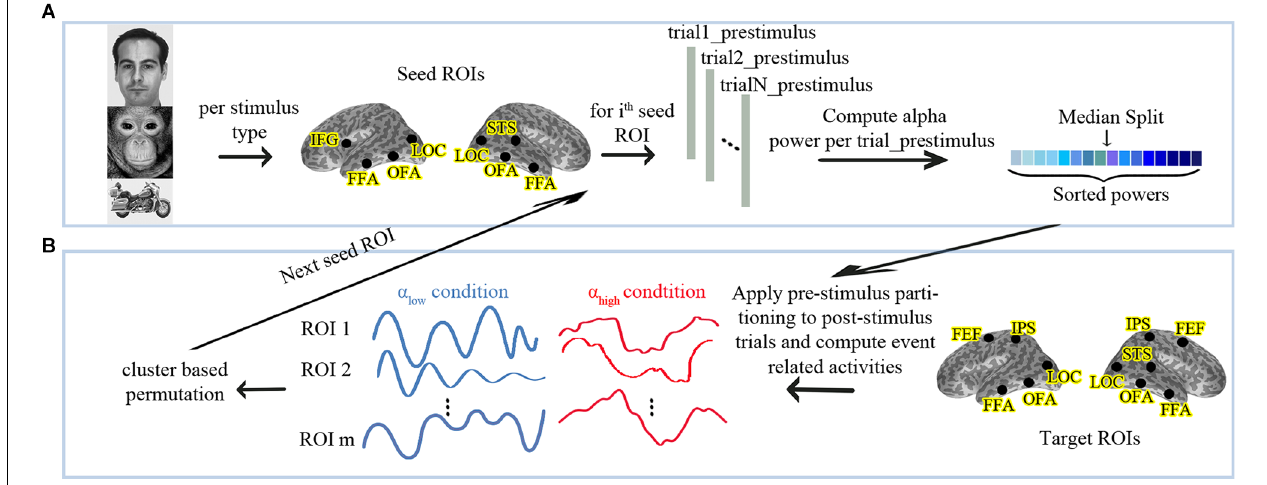
FIGURE 1 | (A) Analysis pipeline for partitioning the data into high vs. low pre-stimulus alpha conditions and (B) follow-up statistics. α low : Low Pre-stimulus Alpha. α high : High Pre-stimulus Alpha. The human face image used in this figure is from the FERETopen source database (Phillips et al., 1998).